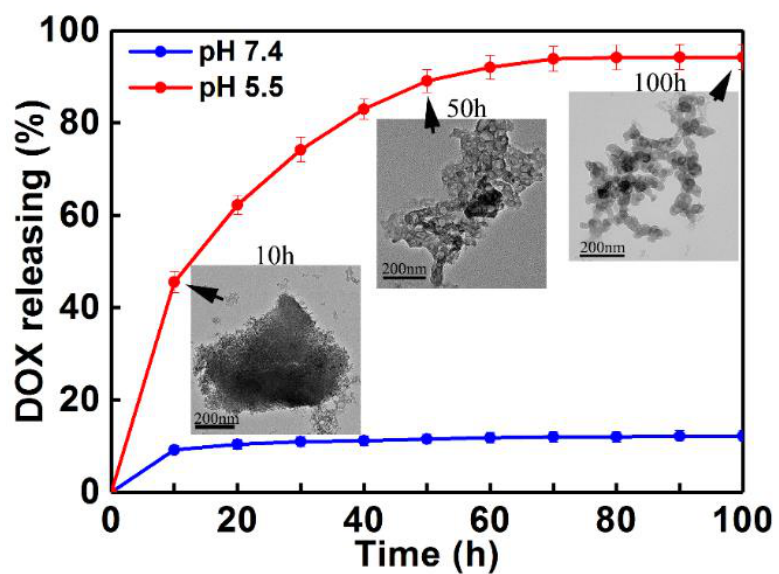
Figure 3. Drug release profiles for DOX-loaded MOGs in PBS buffer solution at pH = 5.5 and pH = 7.4 within 100 h. (Inset are TEM images of DOX-loaded MOGs after 10 h, 50 h, and 100 h in release process at pH 5.5.) Bars denote the standard deviation (±SD, n = 5).